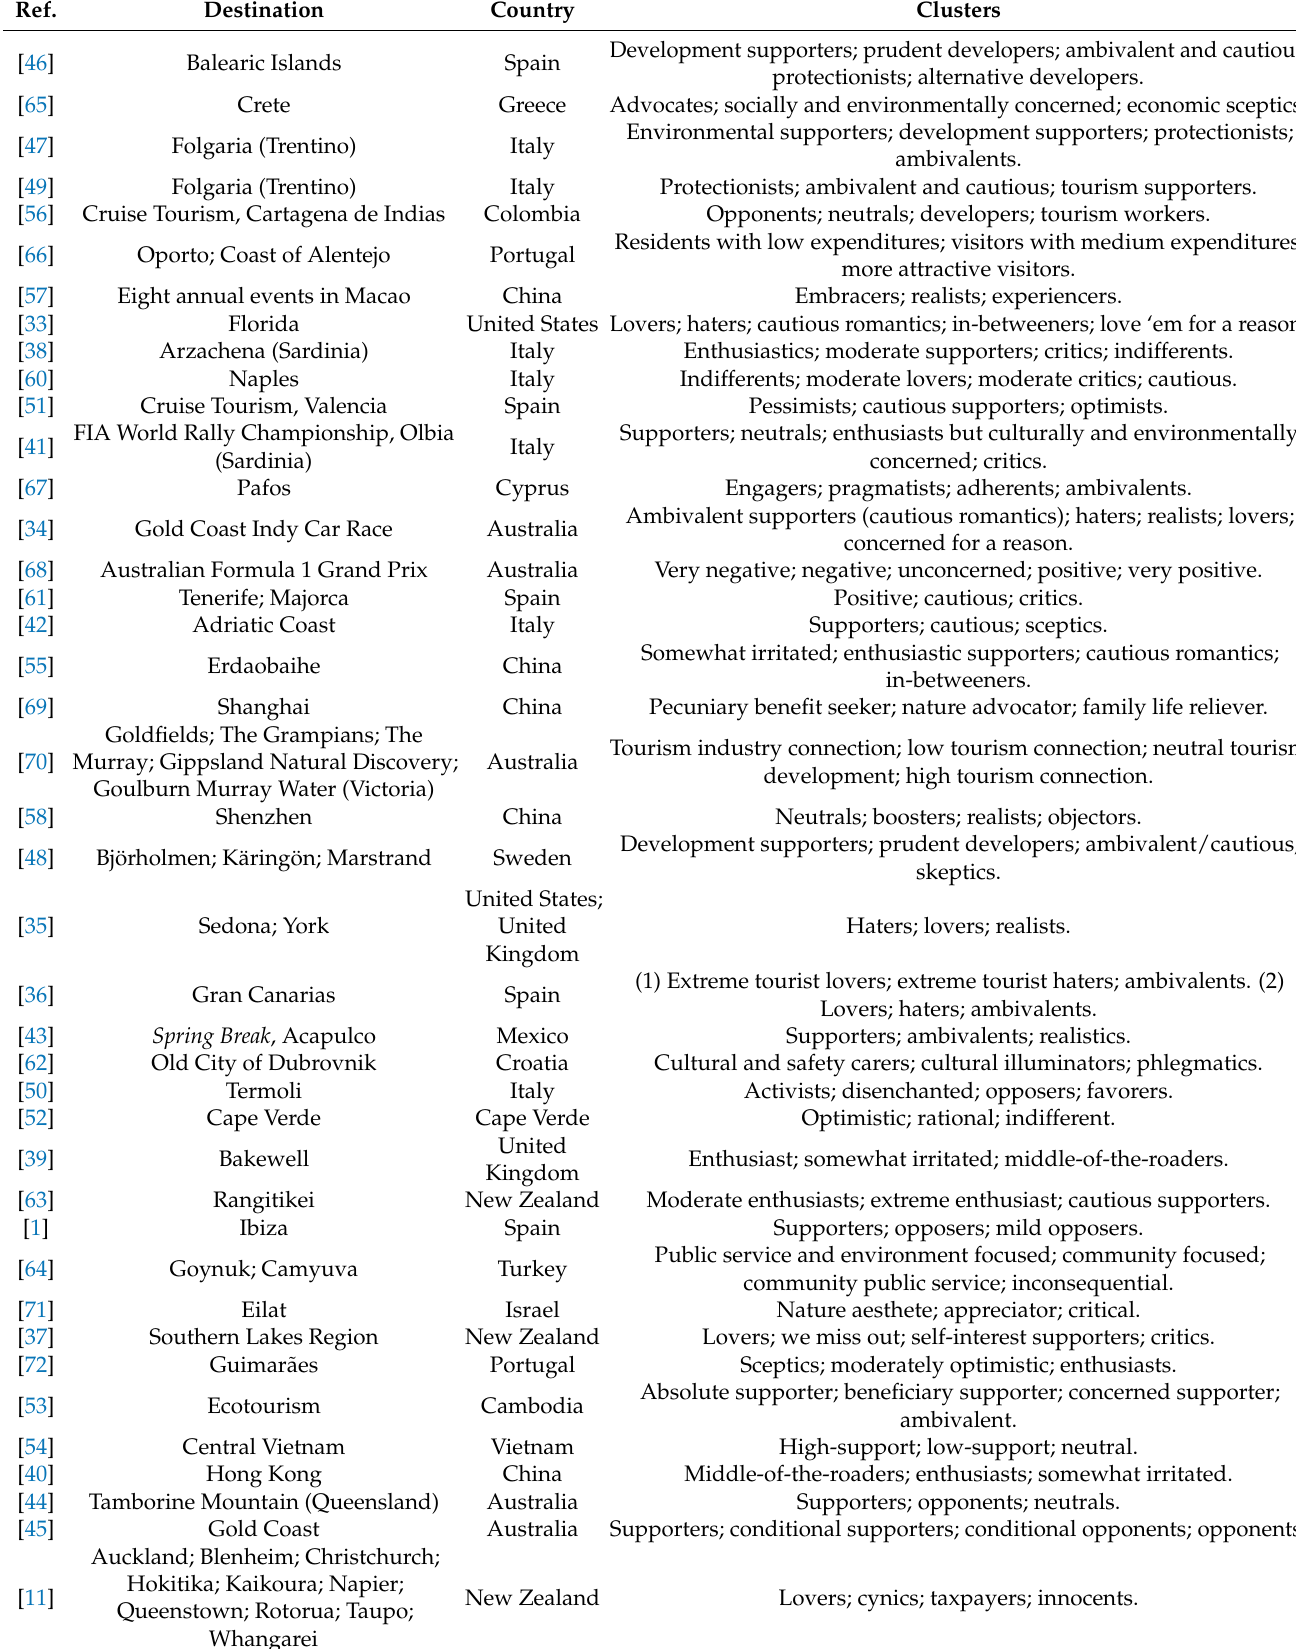
Table 1. Previous cluster analysis papers (own